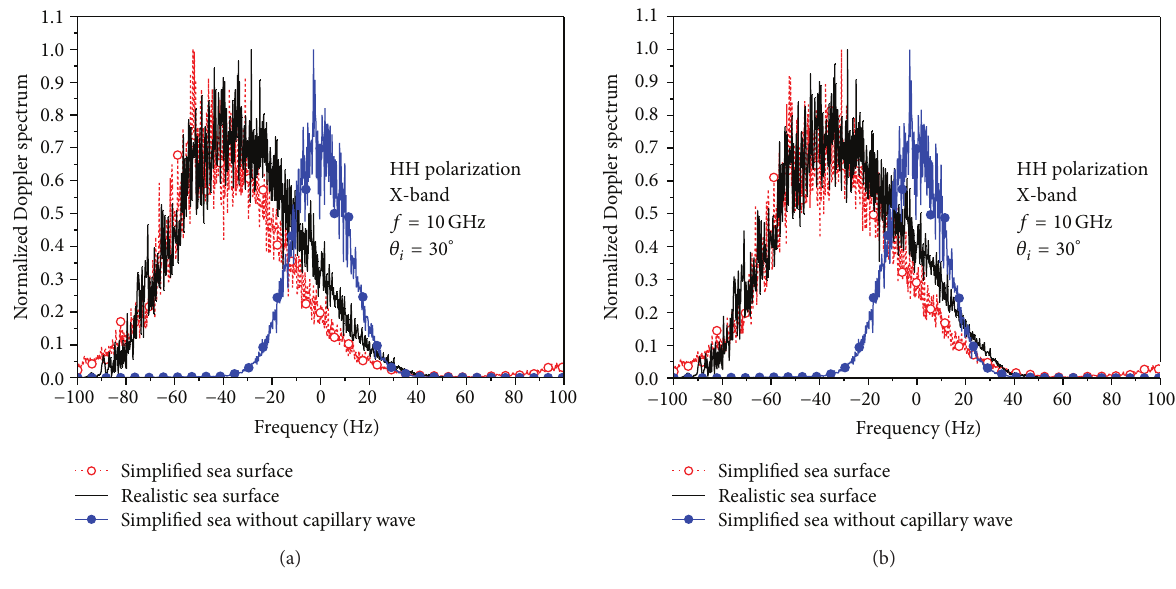
Figure 5: Doppler spectra from time varying sea surface, (a) HH and (b) VV.